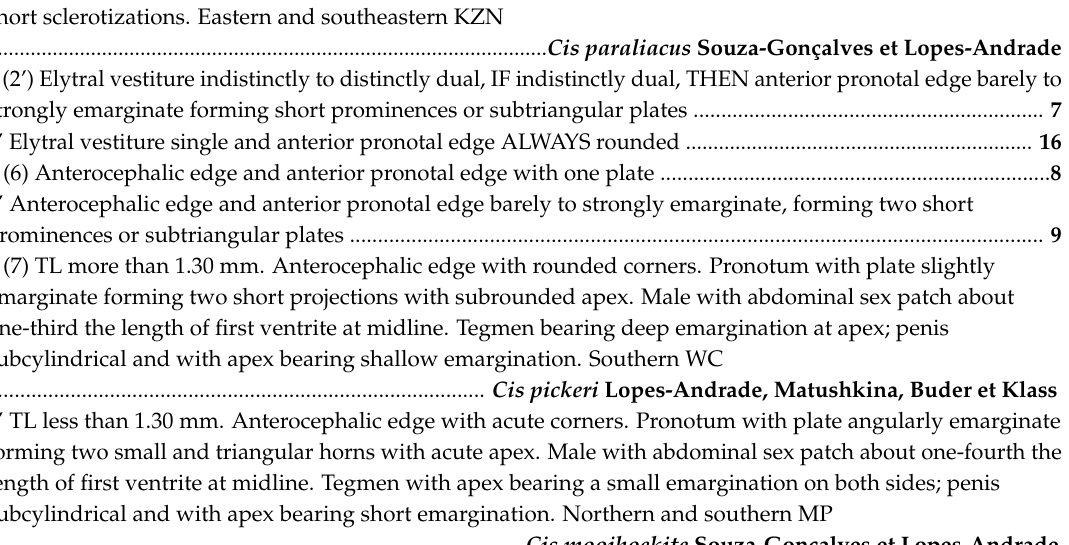
length of first ventrite at midline. Tegmen with apex bearing a small emargination on both sides; penis subcylindrical and with apex bearing short emargination. Northern and southern